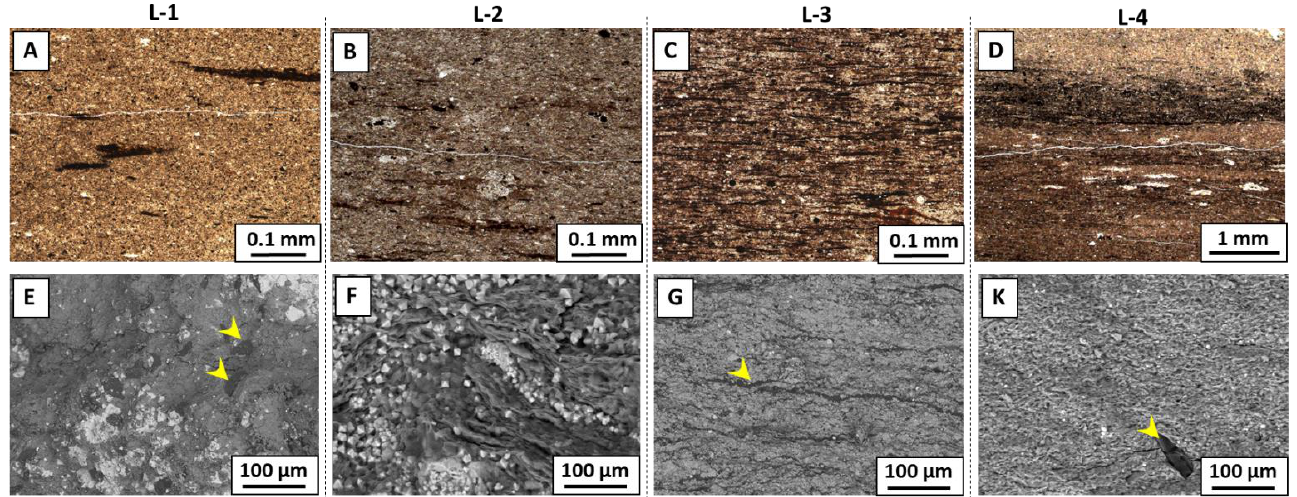
Figure 3. Main lithotypes presented in the studied section: ( A – D) — thin-section images, ( E – G , K) — SEM images. Arrows indicate organic matter, two lithotypes are characterized by the lenticular distribution of organic matter in rock (L-2, L-3), and L-1, L-4 show patchy distribution with minor lenticular organic matter.